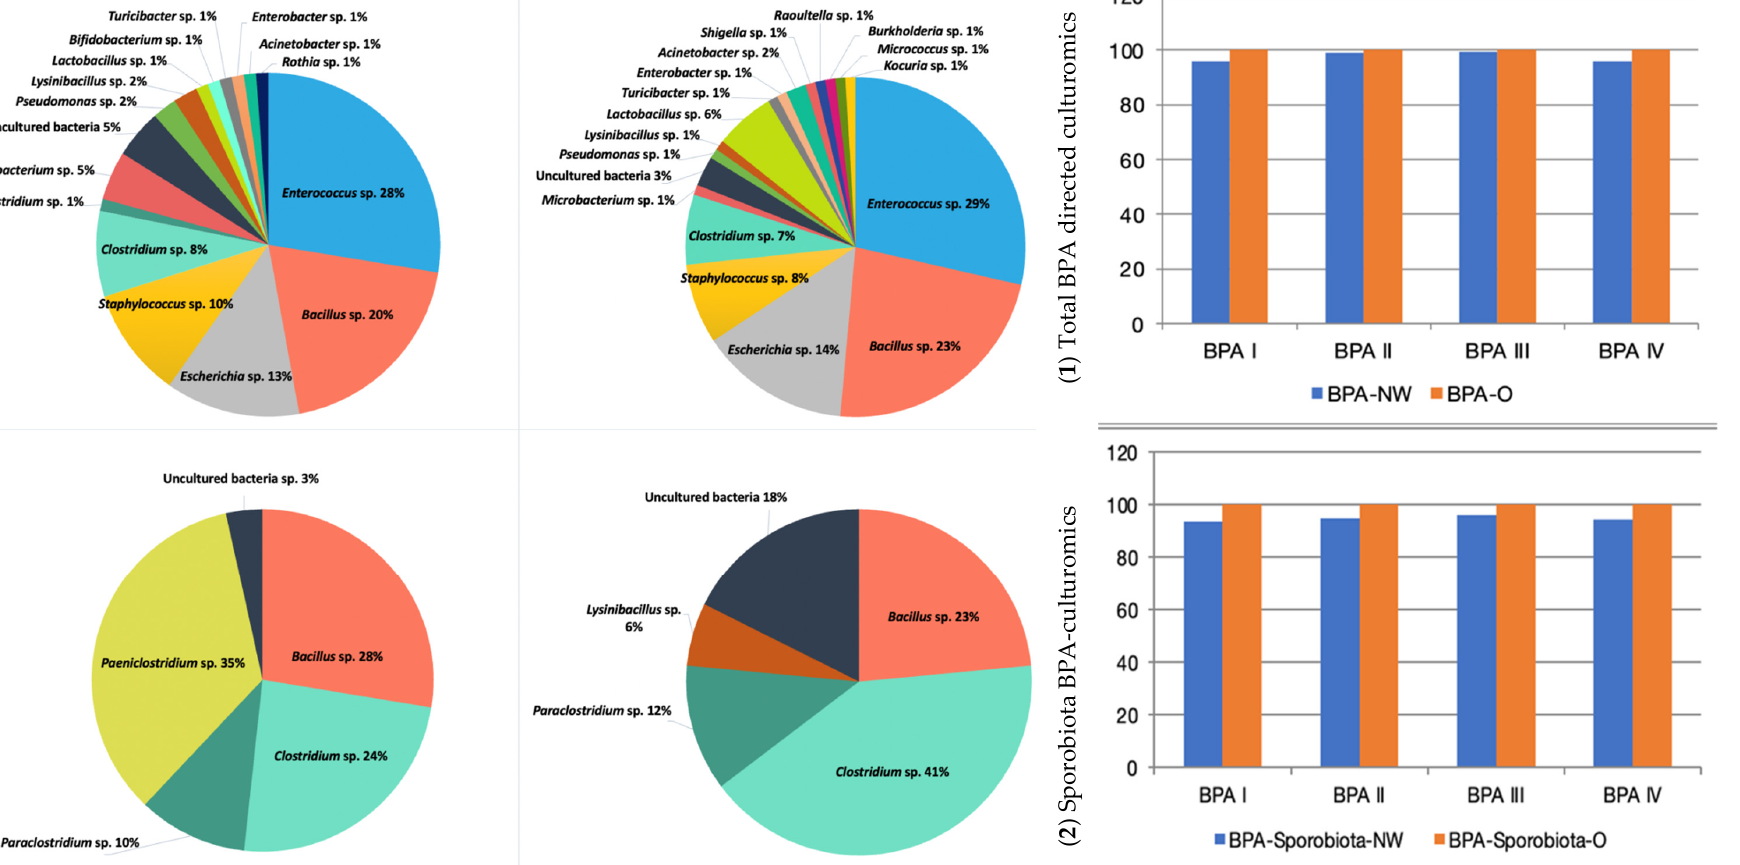
Figure 3. Percentages of microbial taxa abundance distribution of isolated genera after BPA treatments in Normal-weight ( A ); Overweight/Obese samples ( B ) and its Potential BPA Biodegradation capability ( C ) (proportion of BPA degradation genes) according to ( C1 ) Total BPA directed culturomics ( C2 ) Sporobiota BPA-culturomics approach. Normal-weight (NW); Overweight/Obese (O).